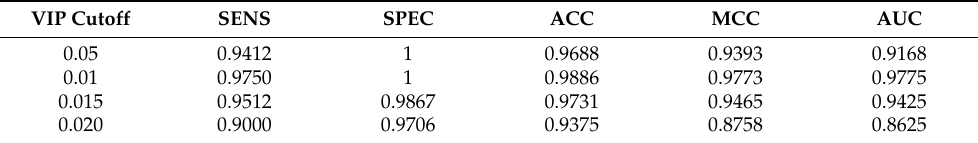
Table 6. Various VIP cutoff values using 4000–600 cm − 1 wavenumber areas for the comparison of LJF and